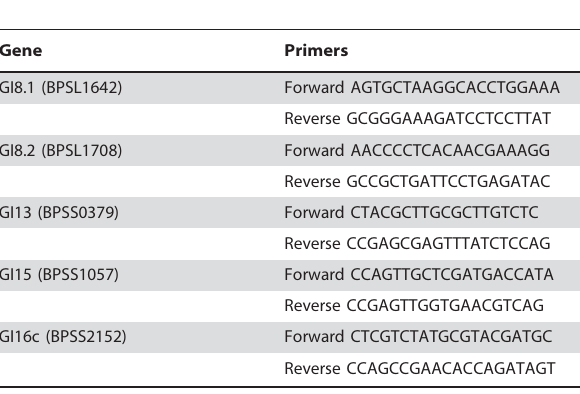
Table 5. Primer sequences used to detect 5 GIs in all B. pseudomallei isolates (139